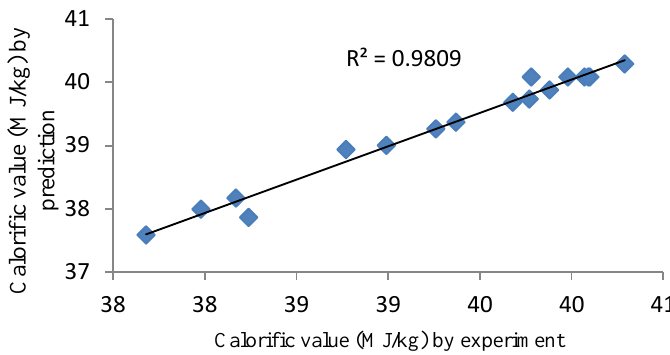
Figure 8. The plot of the experimental versus predicted rice bran methyl ester (RBME) blending with multi-walled carbon nanotubes (MWCNTs) calorific value using artificial neural network (ANN).